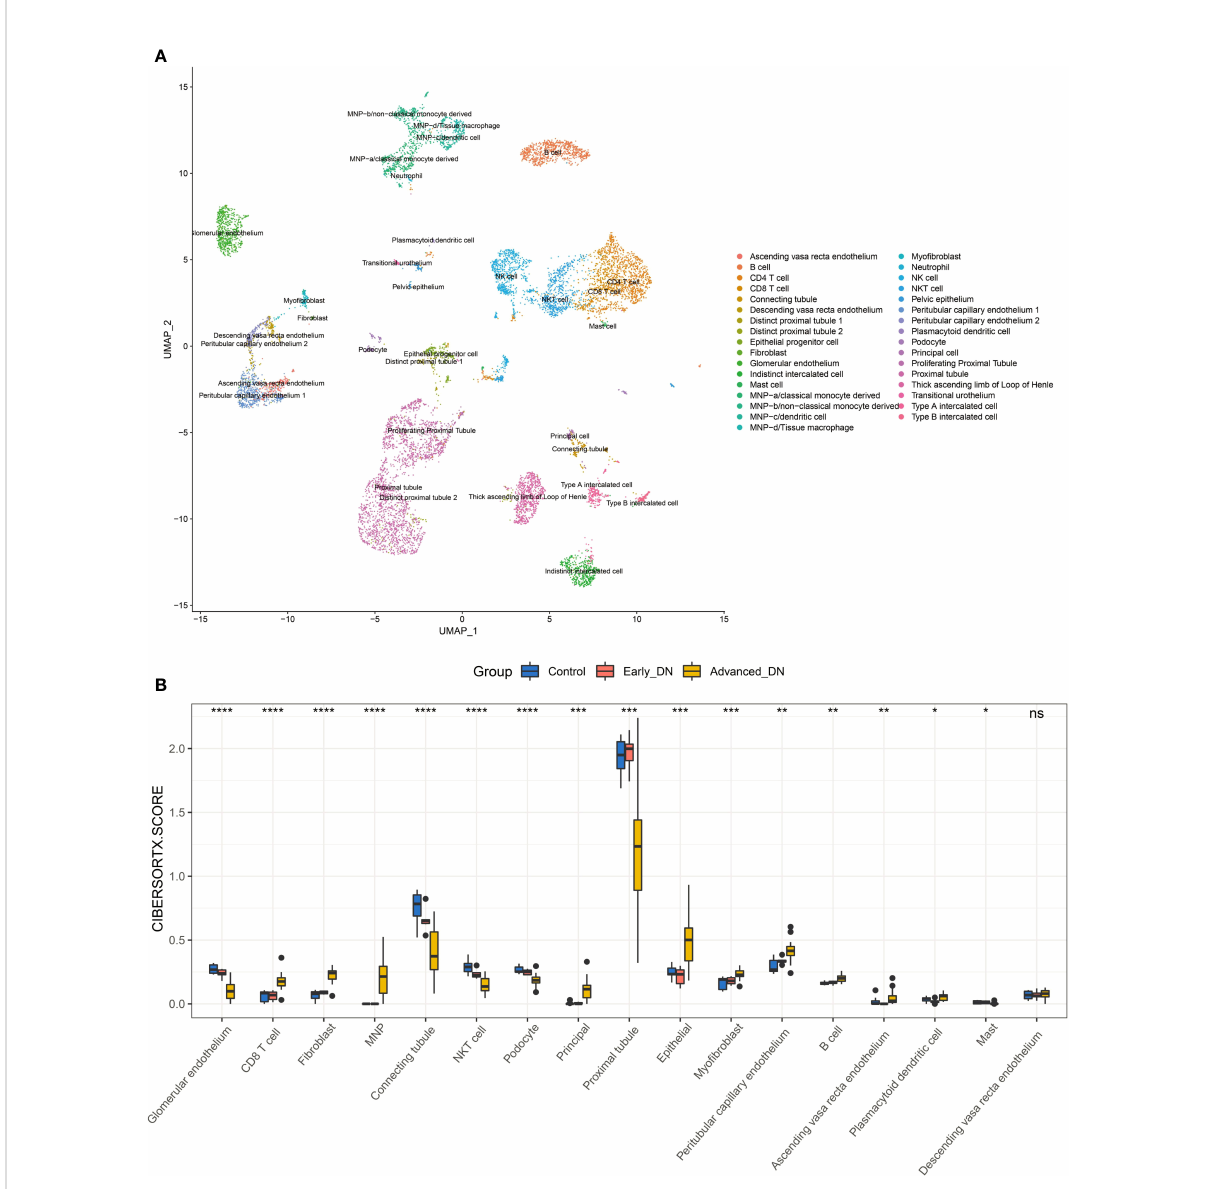
FIGURE 4 Kidney tissue microenvironment in patients with diabetic nephropathy. (A) Dimensionality-reduced clustering plot of reference kidney single- cell sequencing data. (B) Comparison of microenvironmental components in DN kidney tissue. Wilcoxon-Test was used for statistical testing. ****P<0.0001, ***P < 0.001, **P < 0.01, *P <